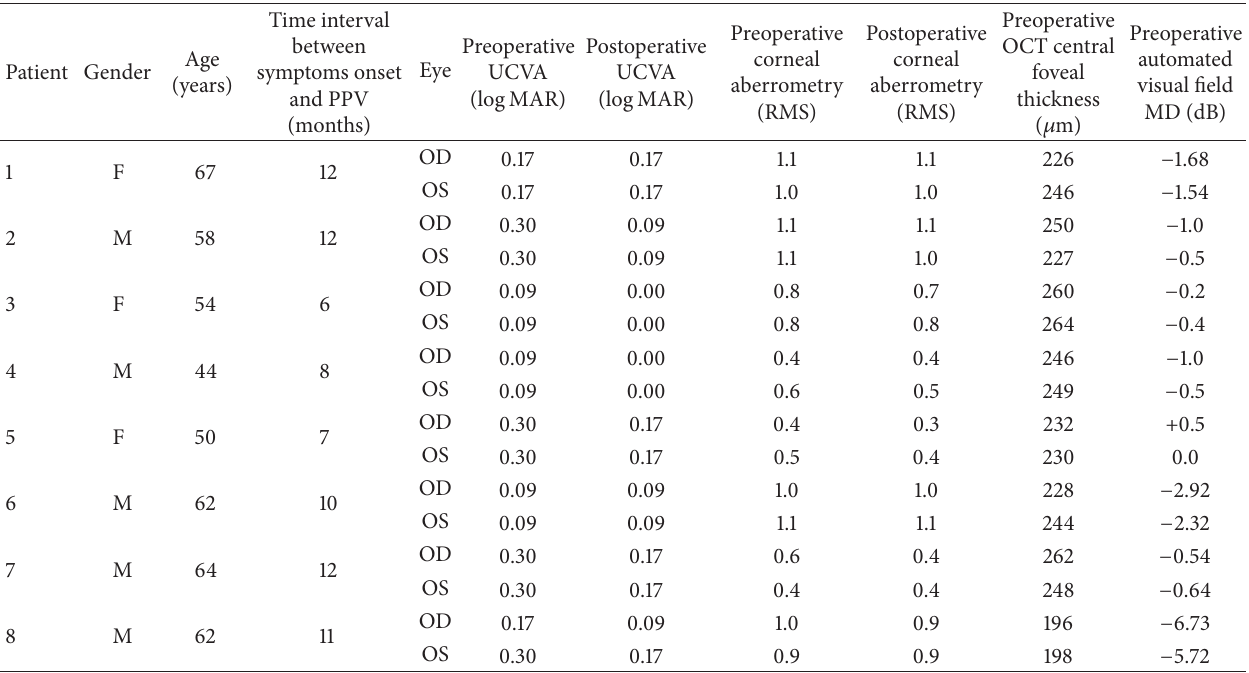
Table 1: Baseline patients’ characteristics and uncorrected visual acuity testing in both eyes prior to and after 23-gauge sutureless pars plana